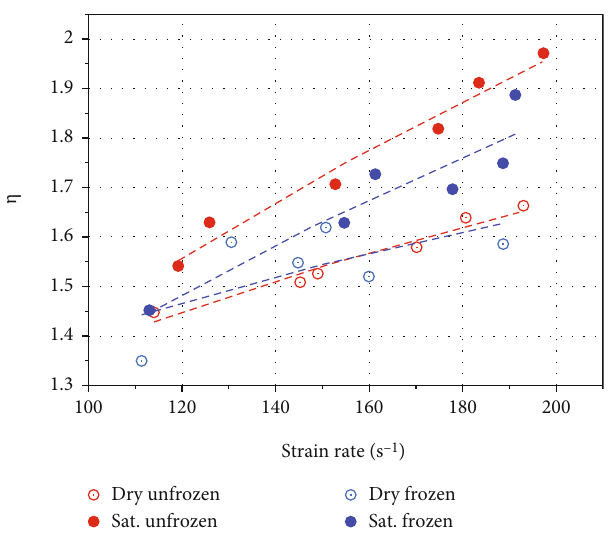
Figure 9: Variations of dynamic increasing factor against strain rate.